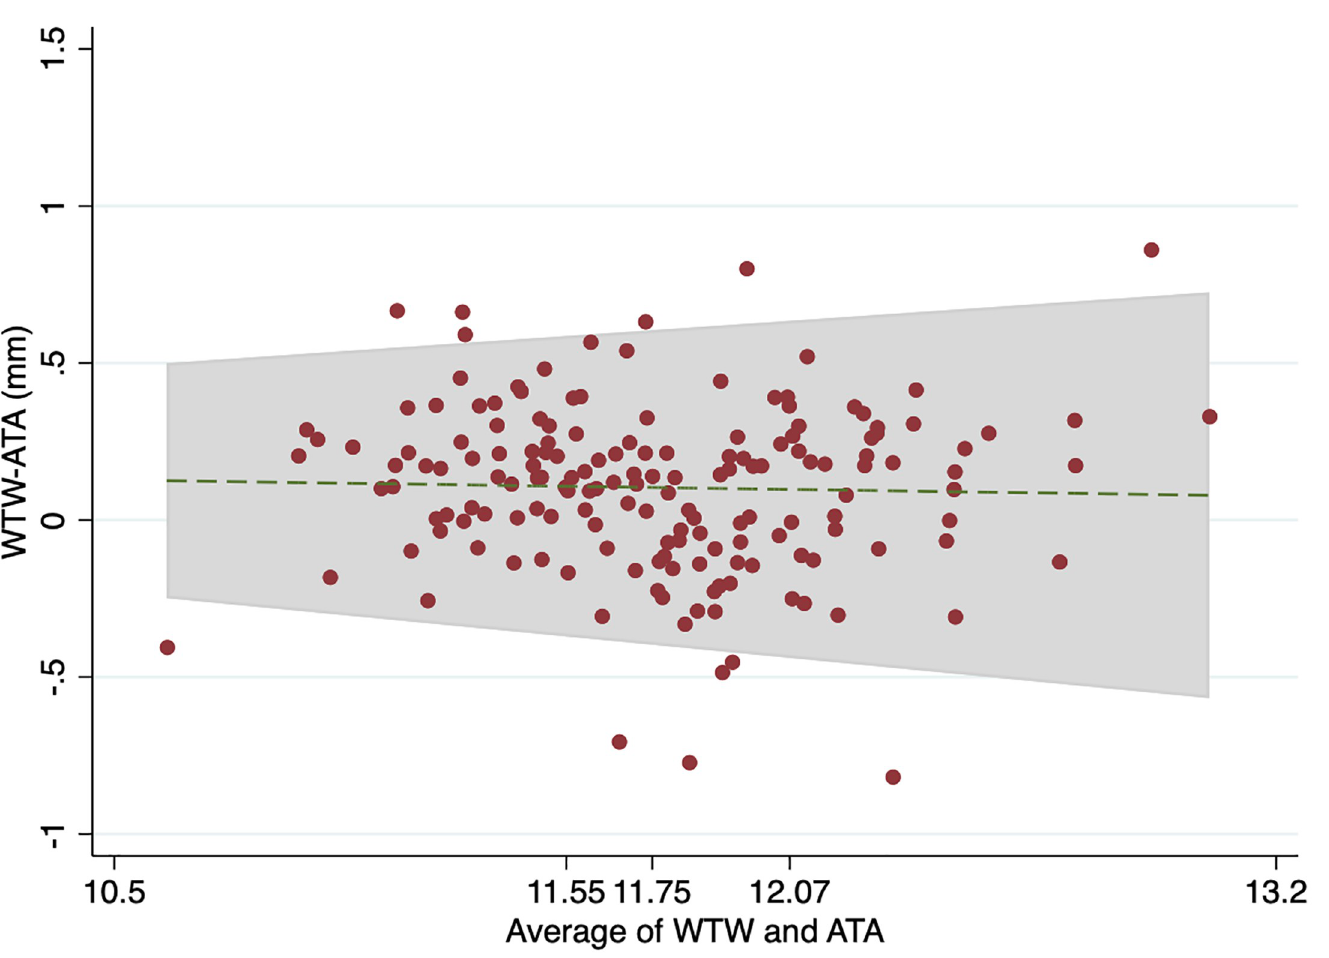
Fig 5. Bland-Altman plots with trend for WTW-ATA and average of WTW and ATA. WTW value of equal to or less than 11.55 mm is a first quartile, value of 11.55 to 11.75 mm represents the second quartile, value of 11.76 to 12.07 mm represents the third quartile, and value of greater than 12.07 mm is a fourth quartile. WTW white-to-white distance; ATA angle-to-angle